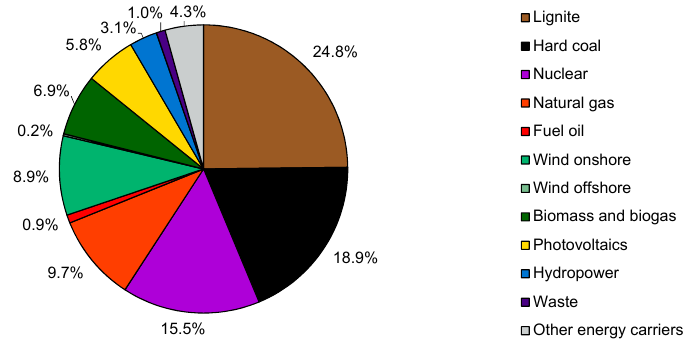
Figure 1. Gross electricity production in Germany in 2014 by energy carrier based on data from [17].